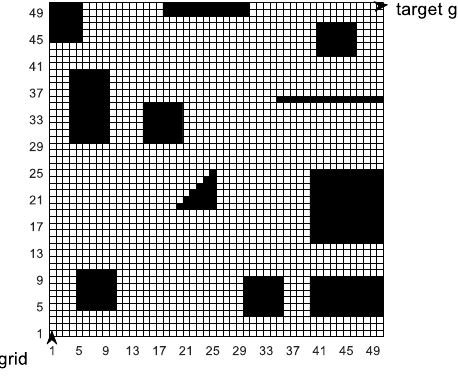
Figure 18. 50 × 50 grid simulation map.